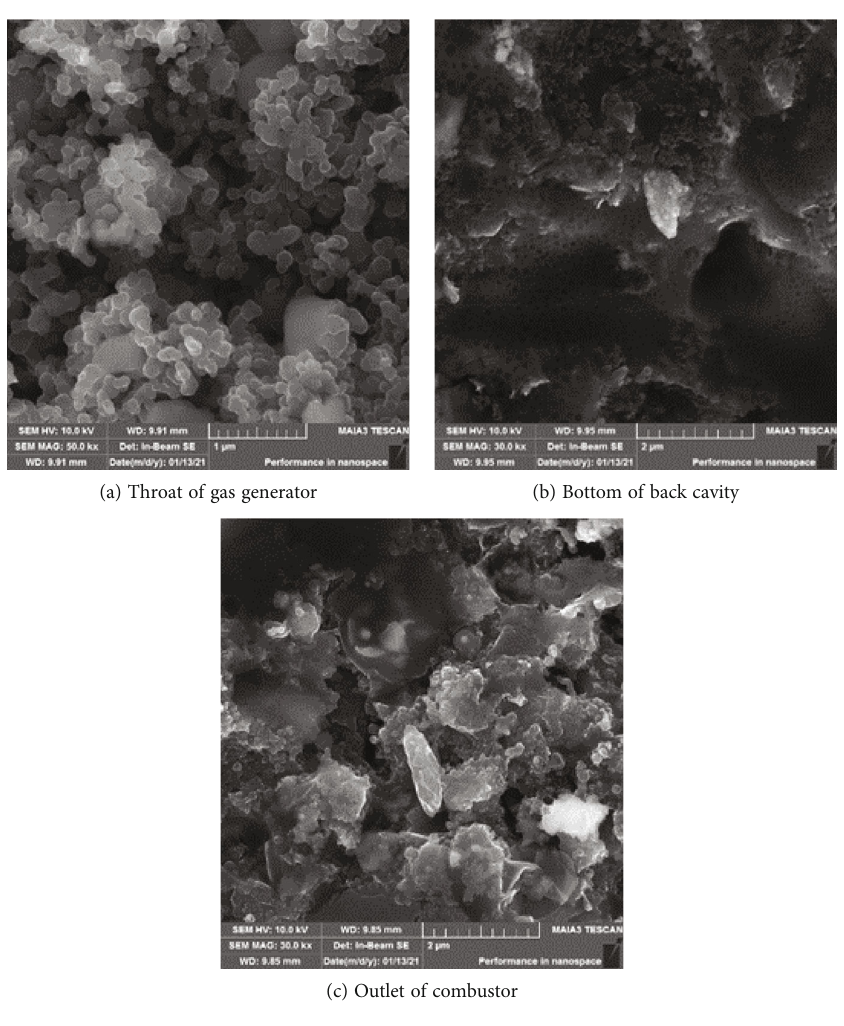
Figure 15: SEM of the products in di ff erent